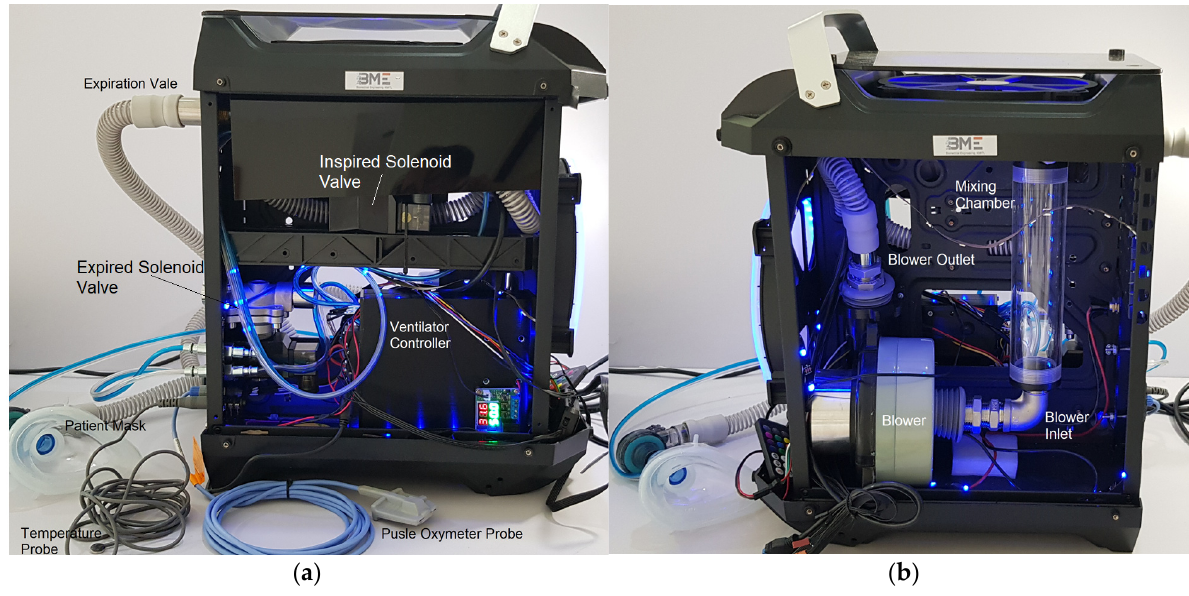
Figure 10. Ventilator chassis: ( a ) electronic chamber and ( b ) pneumatic chamber.